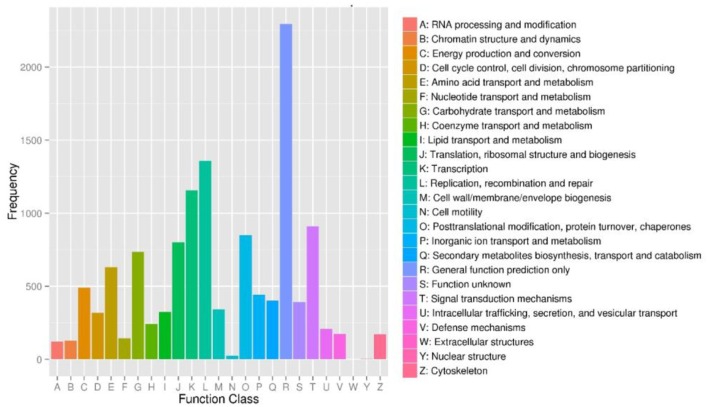
Cluster of orthologous groups (COG) functional classification of unigenes of Lilium ‘Siberia’ petals. From a total of 35,749 final unigenes, 9,183 annotated unigenes with significant homology in the COG database (E−value ≤ 1.0 E−5) were classified into 25 KOG categories.